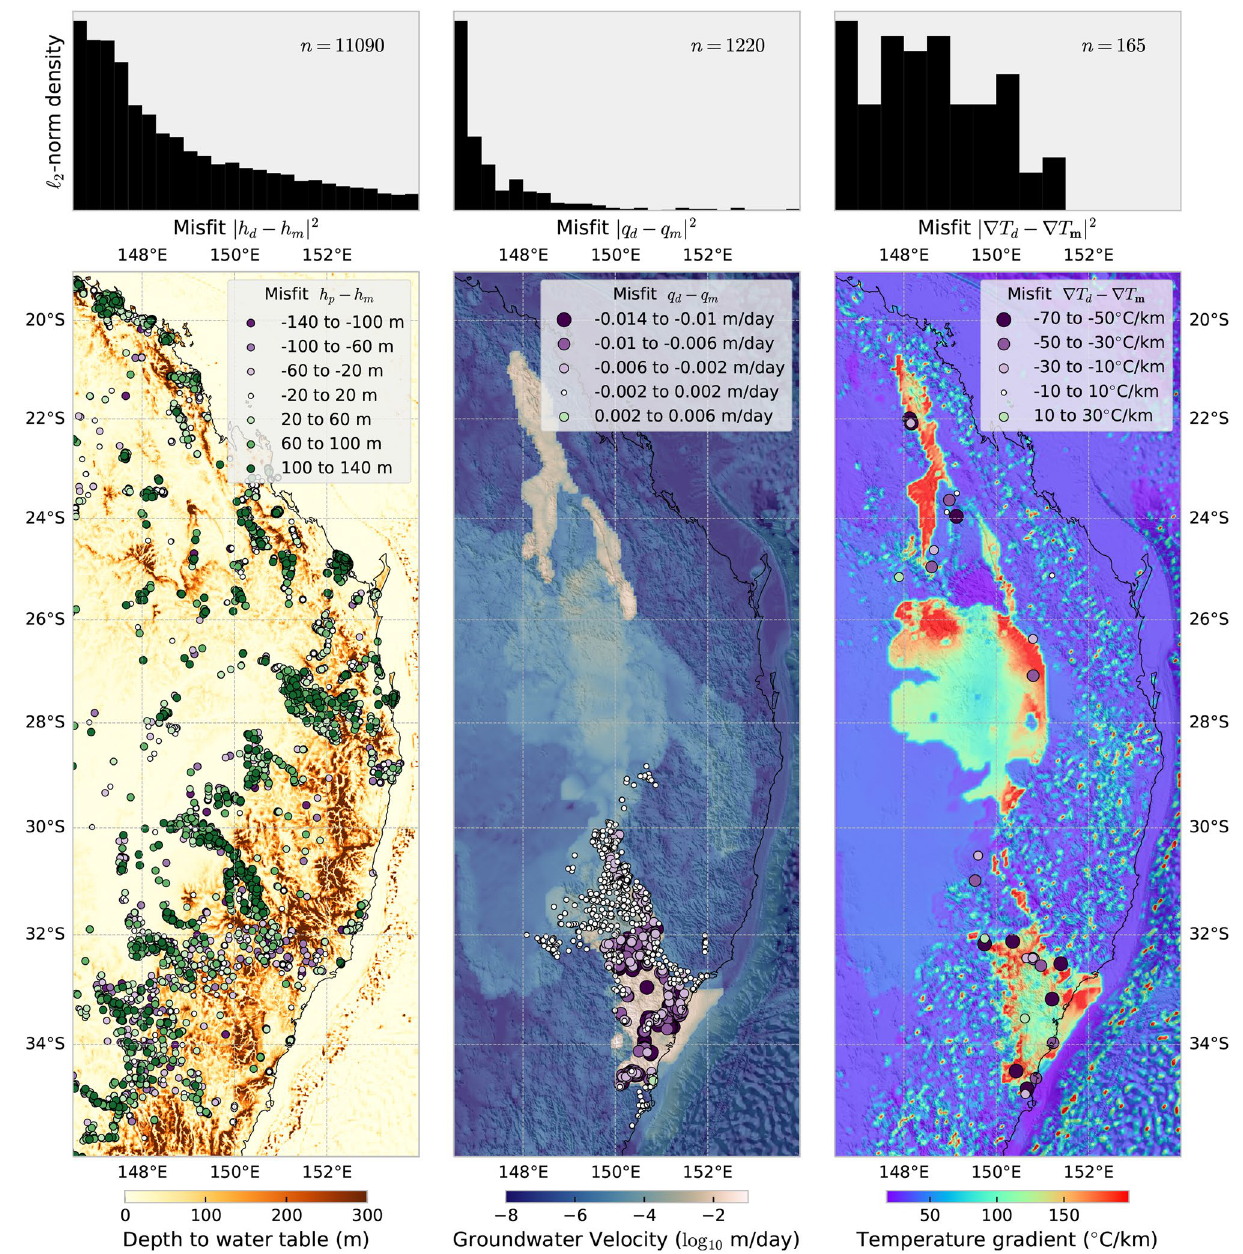
Figure 5. Map of misfit between simulated groundwater pressure, velocity and temperature gradients (from the MAP estimate) with borehole observations. The ℓ 2 -norm misfit histograms indicate the optimal fit between model and data. These maps were generated from our models using Cartopy 0.19 (https:// scito ols. org. uk/ carto